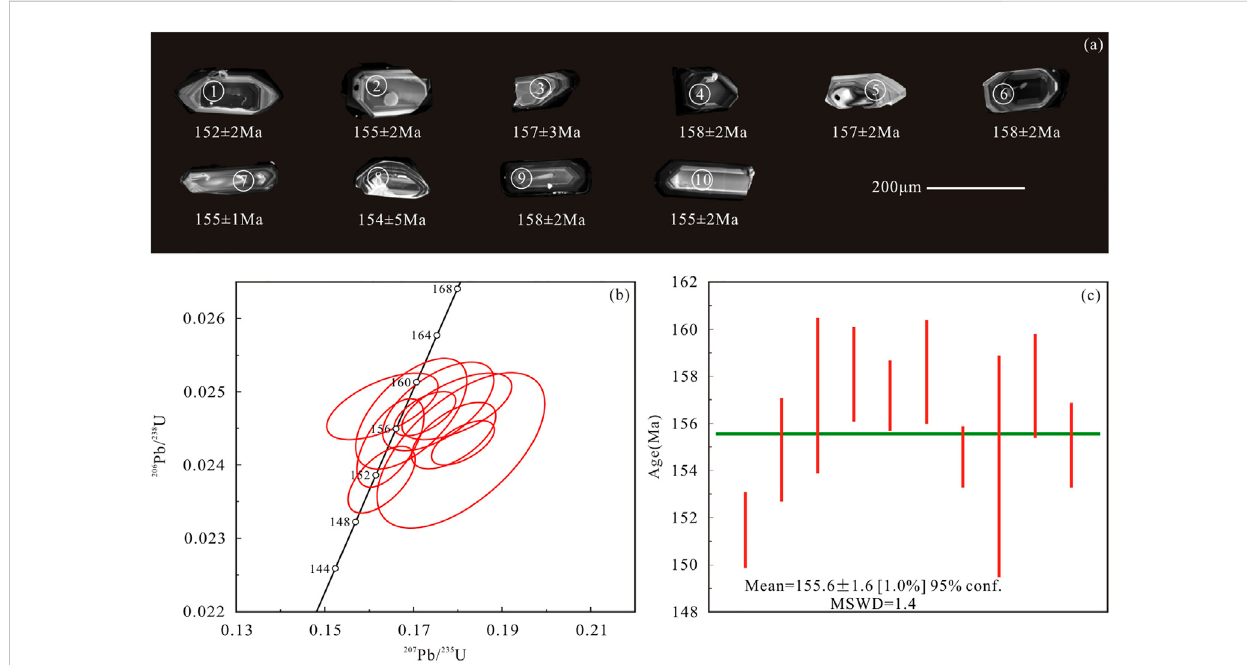
FIGURE 6 (A) Representative cathodoluminescence (CL) images, (B) concordia curves, and (C) weighted mean age of LA-ICP-MS U-Pb data for the granite in